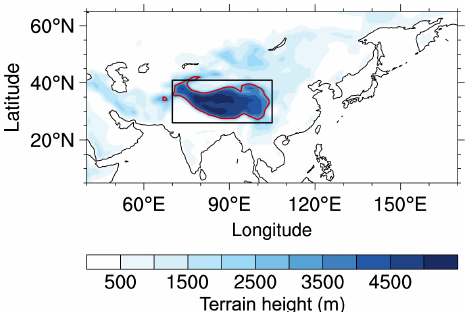
Figure 1. The location and topography of the Tibetan Plateau. Shad- ing shows topography (unit: m). The black rectangle shows the re- gion within 26–41 ◦ N and 70–105 ◦ E. The red contour marks al- titudes at 3000m. The Tibetan Plateau area, which is the focus of this study, is the region within the black rectangle at an alti- tude of greater than 3000m. This figure also shows the simula- tion domain for numerical experiments in this study. The map in this figure was generated using NCAR Command Language (NCL) version 6.6.2, an open-source software free to the public (https: //doi.org/10.5065/D6WD3XH5, UCAR/NCAR/CISL/TDD,